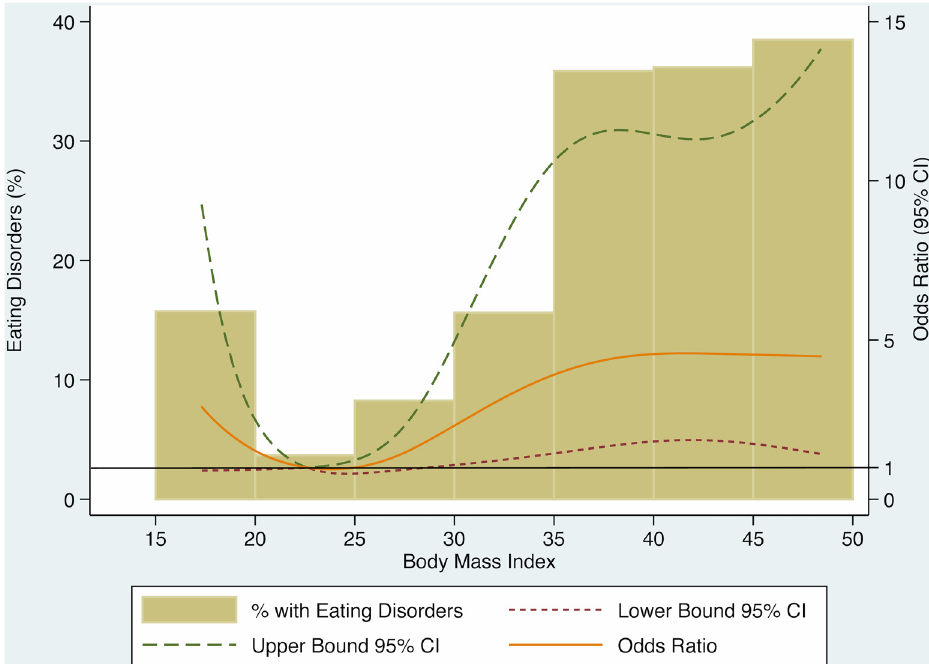
Fig 3. Odds ratio and percentage of eating disorders across the continuum of BMI. Adjusted by age, gender, paid work, educational level, family history of obesity, family history of psychiatric disease, mood disorders, anxiety disorders, adjustment disorders, substance-related disorders, and cluster C personality disorders; CI = confidence Interval.